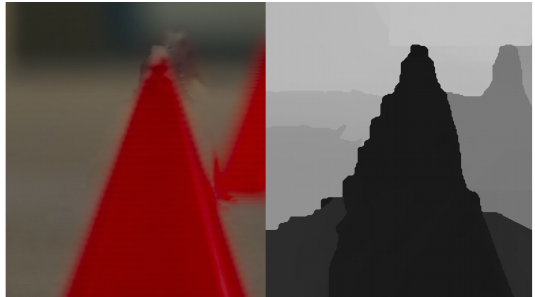
Figure 2. Error while refocusing in image and depth map. The cone is not represented correctly and the transition to the cone in the back appears incorrect.